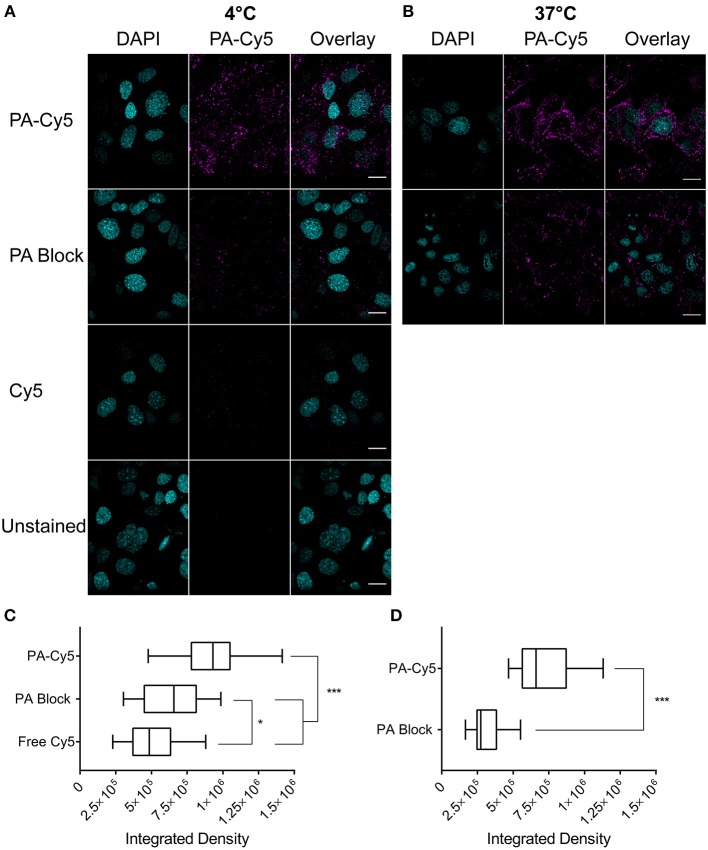
Fluorescently labeled PA maintains cell binding and internalization in vitro. Cells were plated on glass cover slips coated with poly-L lysine at 105 cells/coverslip 18 h before staining. Cells were incubated with PA at 4°C to saturate the available receptor sites prior to internalization (A) or at 37°C for continuous cell uptake (B). Blocking experiments (PA Block) were performed by incubating the cells with unlabeled PA on ice prior to the addition of PA-Cy5. Cells were washed with PBS before fixation in 4 % paraformaldehyde. Analysis of integrated density of Cy5 fluorescence per cell, visualized with box-and-whisker plots, identified PA-Cy5 internalization into SCC cells was significantly reduced by blocking the available receptor sites with unlabeled PA at 4°C (C) and 37°C (D). Cyan, DAPI nuclear stain; magenta Cy5. Scale bar represents 20 μm. Statistical analysis performed using two tailed unpaired T-test with Welch's correction (*p = 0.0495, ***p < 0.0001).